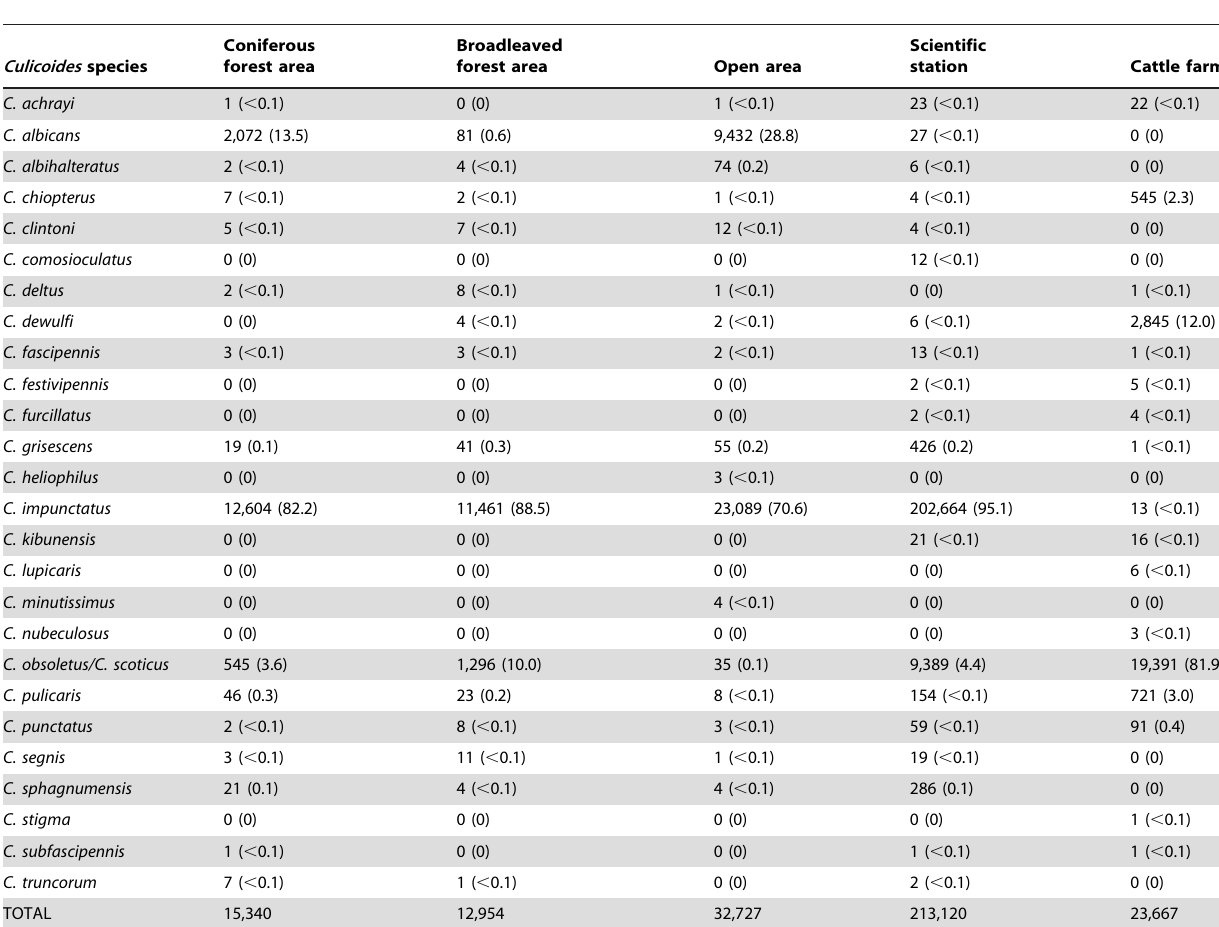
Table 1. Culicoides species composition (number (percentage)) trapped at the five study sites.